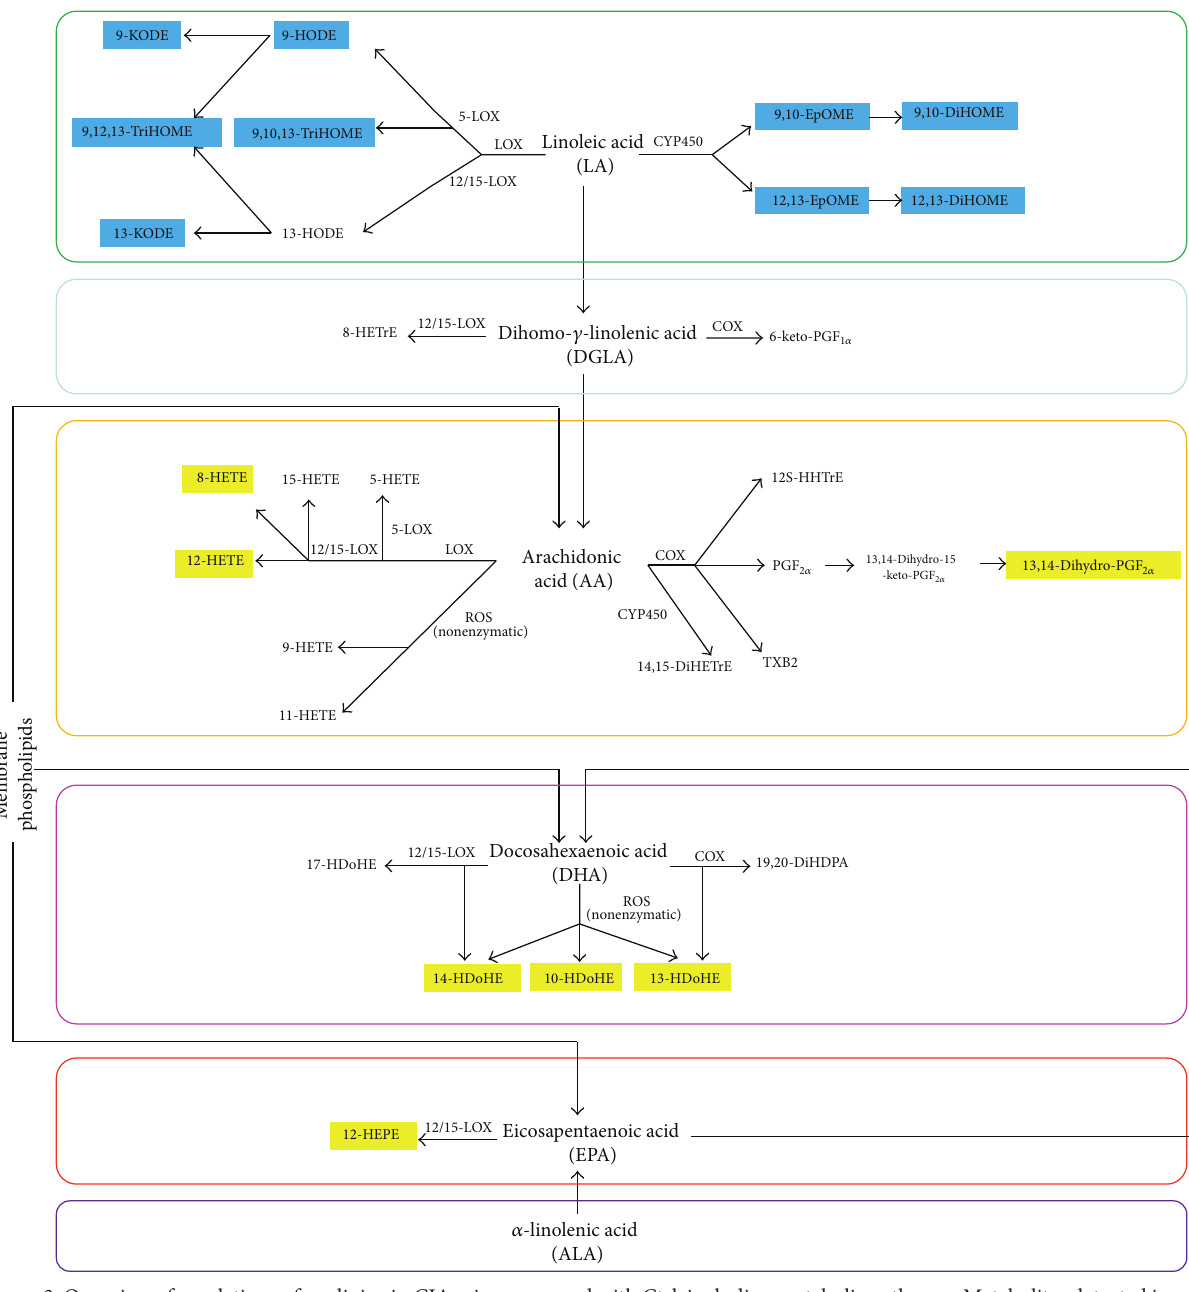
of signaling via PPAR- 𝛾 to inhibit the activation of NF- 𝜅 B, namely, the molecular basis for RA. Interestingly, PPAR- 𝛾 has been identified and reported as a therapeutic agent for arthritis [74]. The reduced levels of linoleic acid derived oxylipins implicated fatty acid precursor pools, shedding light on the unexplored routes of fatty acid elongation pathways in the pathogenicity of RA, and need further work. As additional metabolites have been reported to play a role in RA, a systems biology approach would complement the study of systematic autoimmune induced rheumatoid